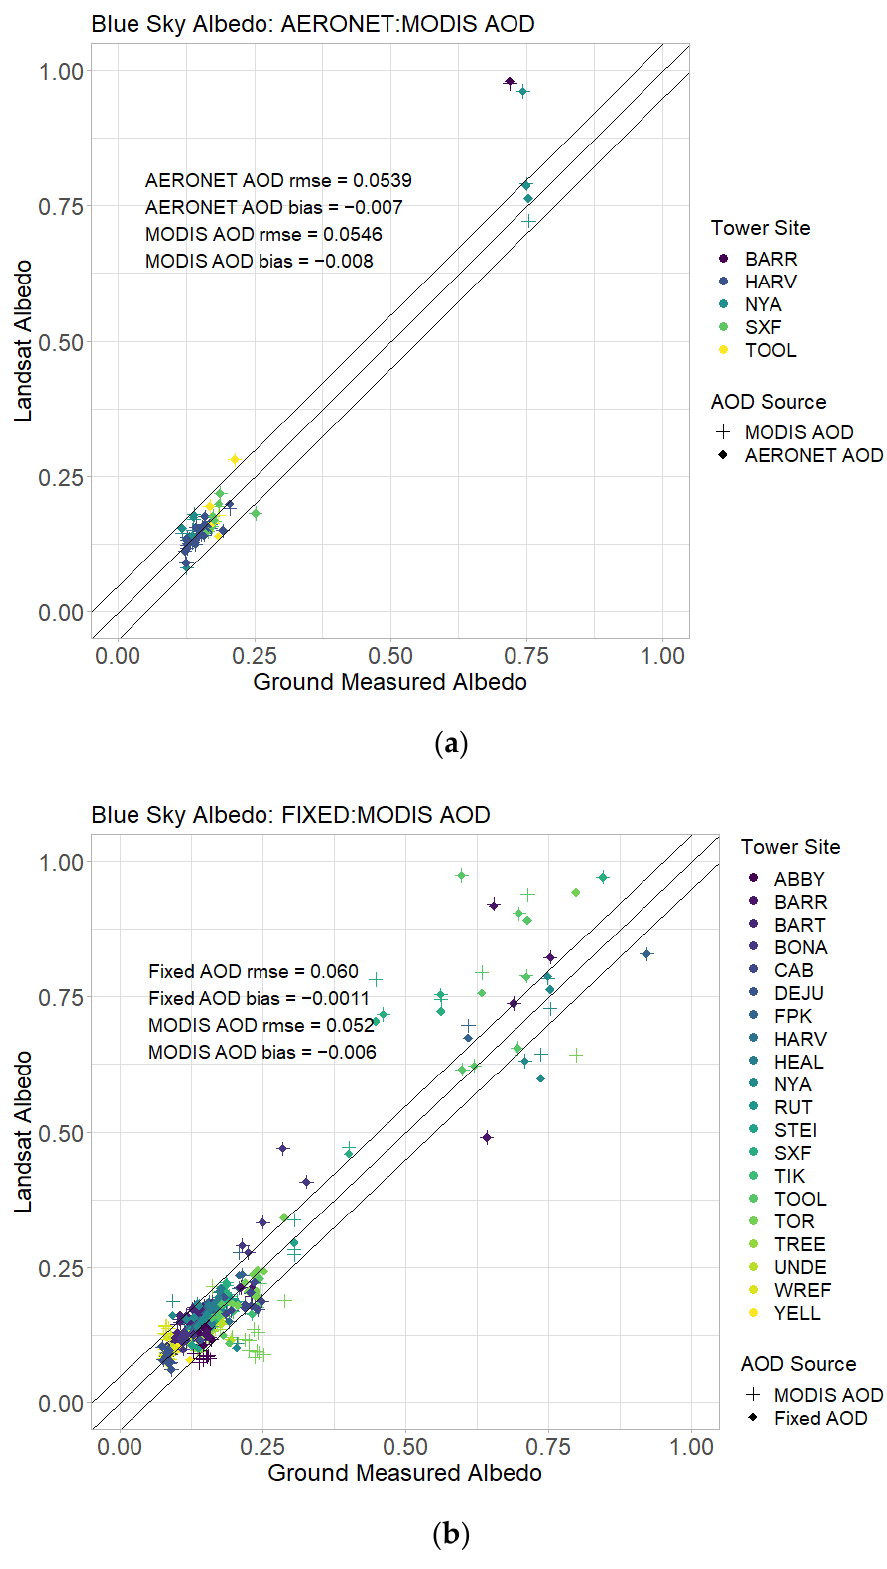
Figure 5. Comparison of blue-sky albedo derivation using Aerosol Optical Depth (AOD) data from different sources: ( a ) The comparison of blue-sky albedo calculated from MODIS AOD and AERONET tower AOD; ( b ) The comparison of blue-sky albedo calculated from MODIS AOD and using a fixed climatology value of